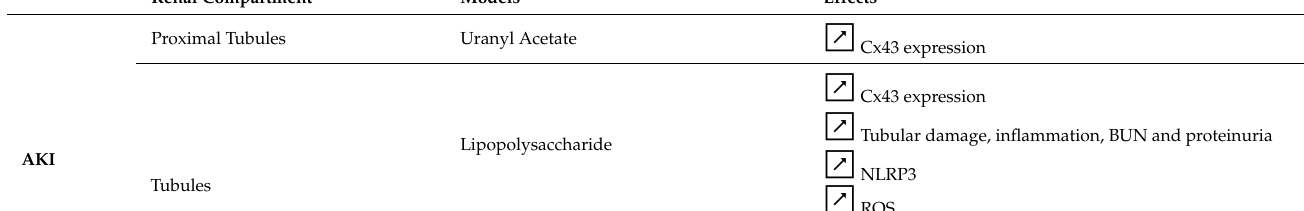
Table 1. Physiopathological functions of Cx43 in different in vivo models of renal disease. Renal Compartment Models